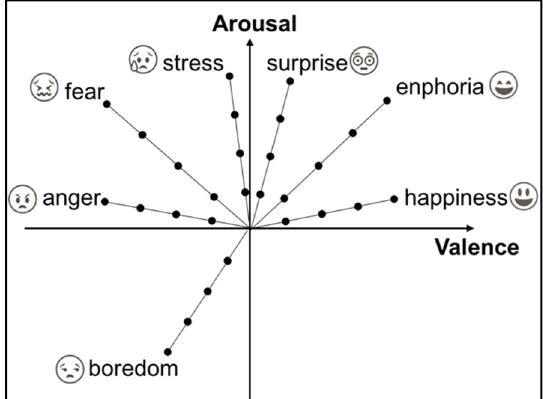
Figure 3. Arousal–valence emotional model.